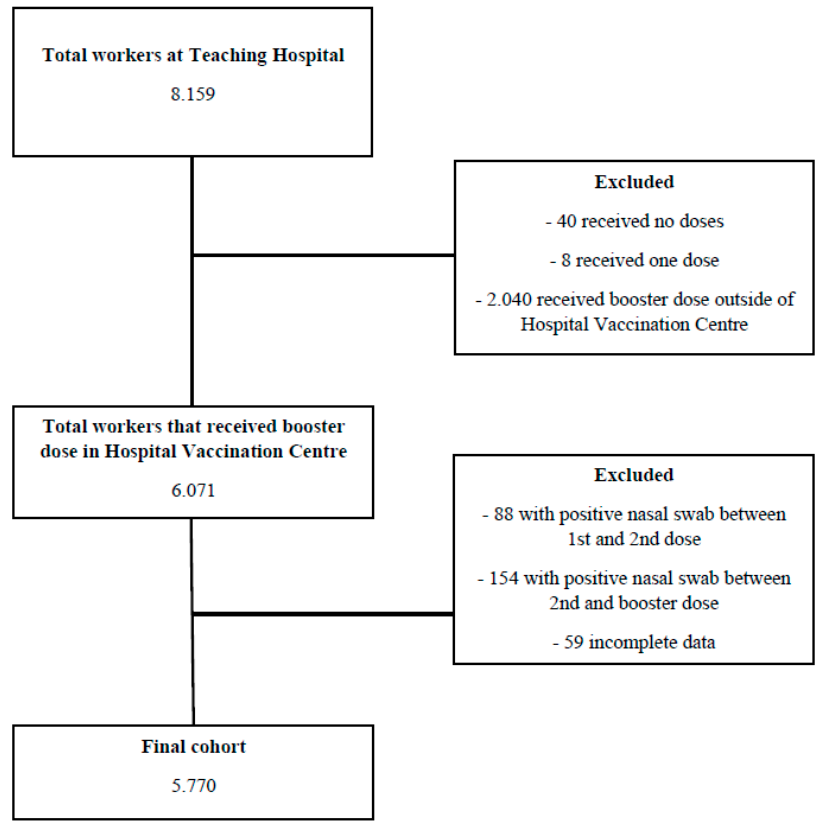
Figure 1. Flow-chart to identify the final cohort.